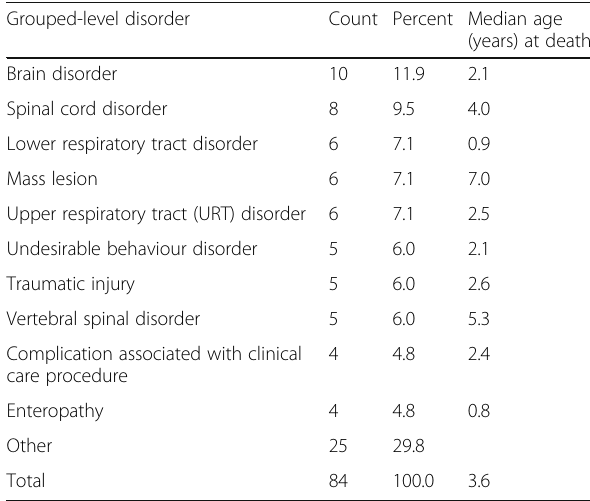
Table 2 Causes of mortality in French Bulldogs with a recorded cause of death under primary-care veterinary at UK practices participating in the VetCompass ™ Programme from January 1st, 2013 to December 31st, 2013 ( n =